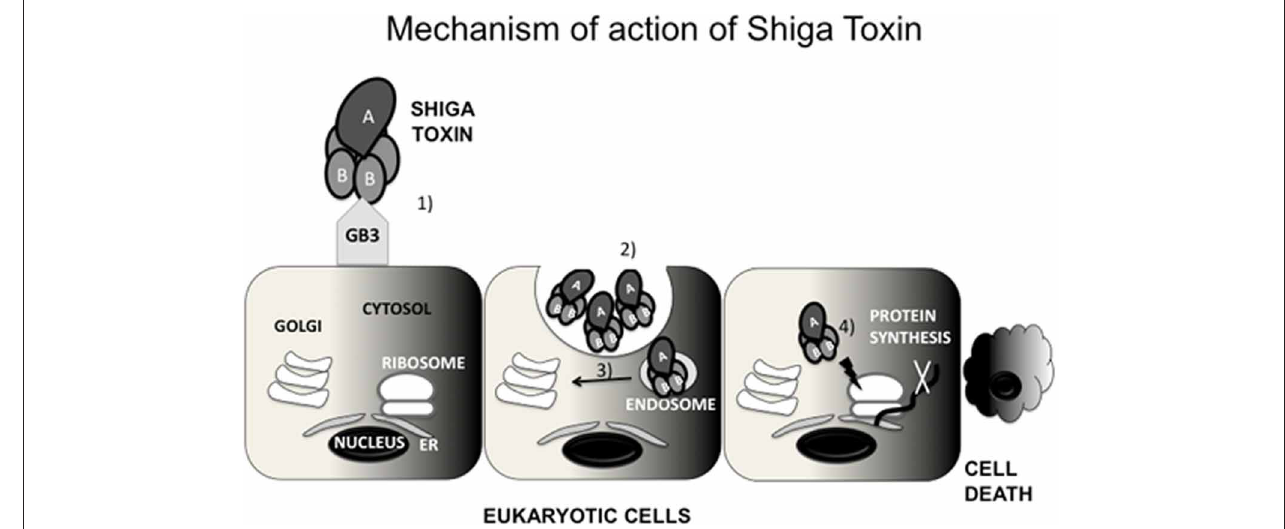
FIGURE 1 | Mechanism of action of Shiga toxin (Stx). Stx is constituted by a pentamer of B subunits bound to a catalytic A subunit. The B subunits bind to globotriaosylceramide (Gb3) expressed by some eukaryotic cells (1) Stx is internalized by endocytosis (2) Subsequently, Stx undergoesretrograde